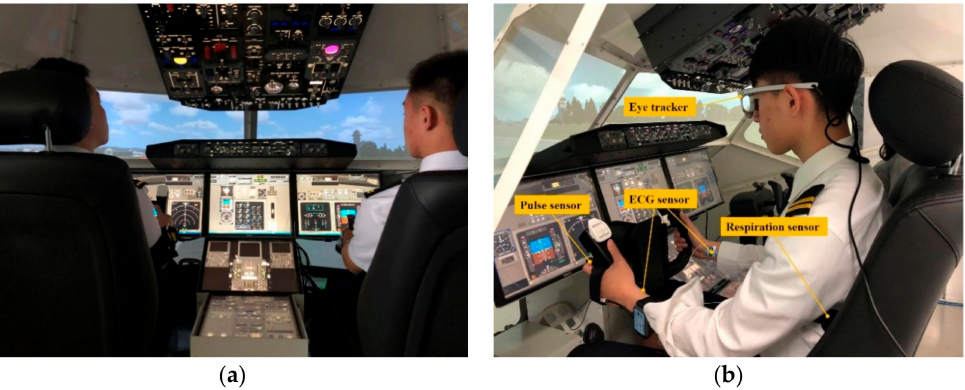
Figure 5. Experiment scenes of flight simulation. ( a ) Flight simulation experimental platform. ( b ) Flight personnel wearing physiological monitoring sensors during the